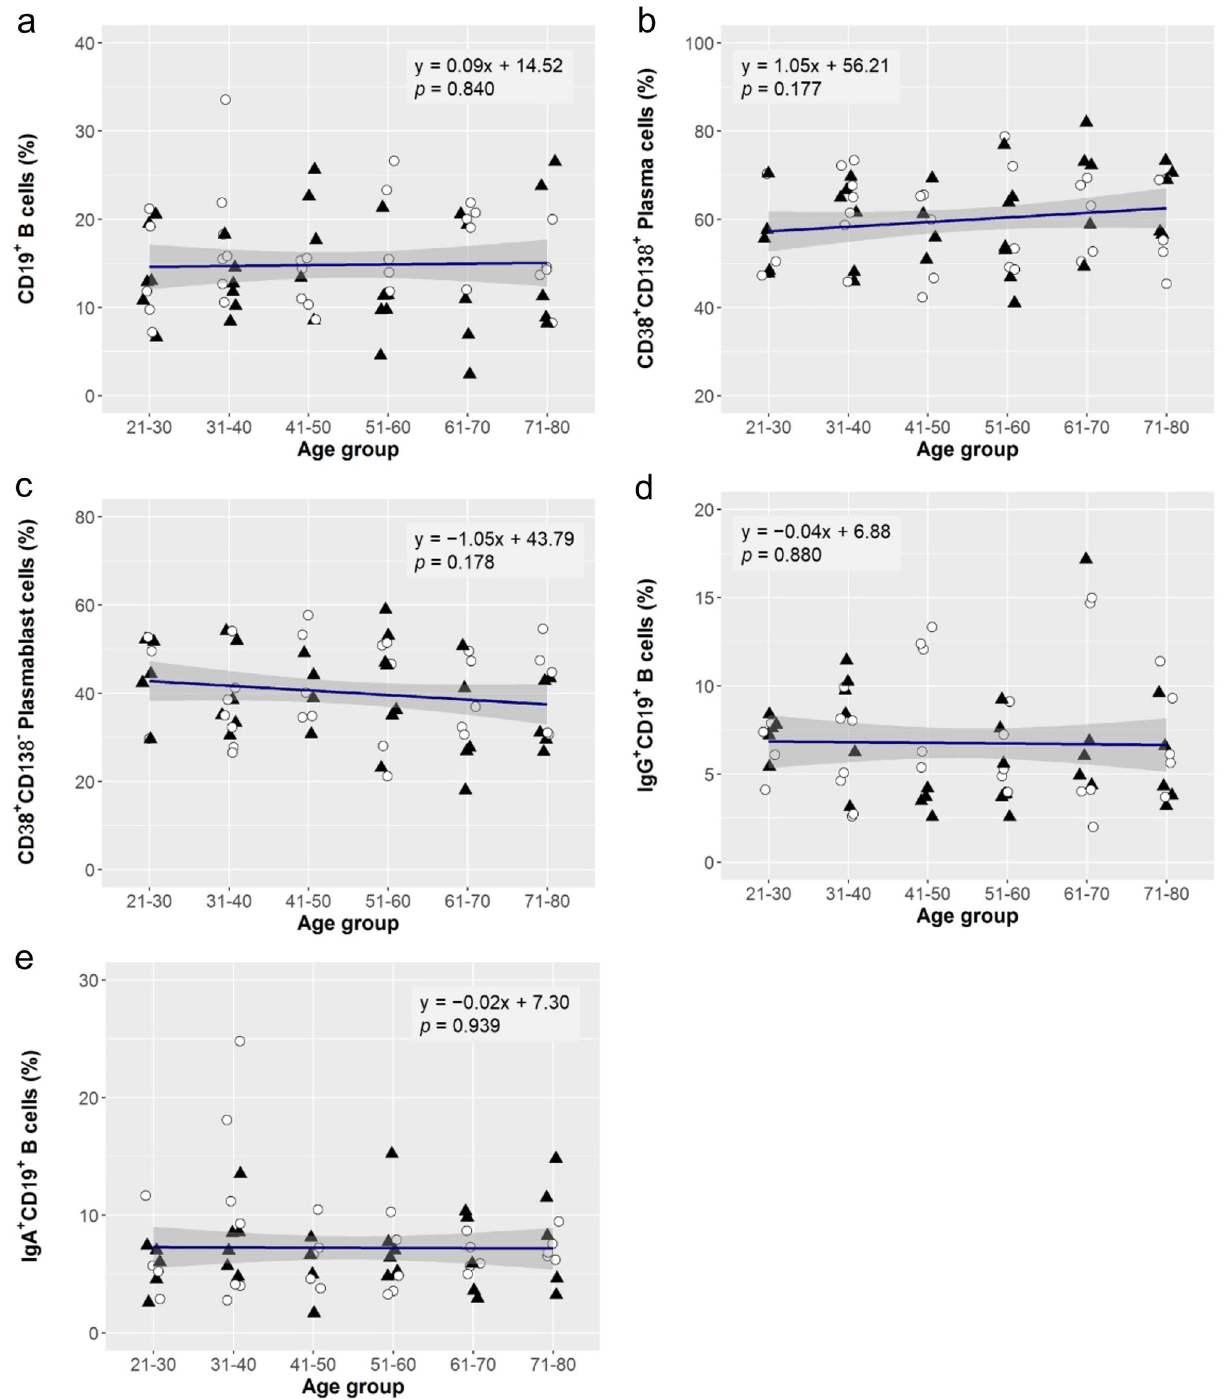
Figure 3. Age-associated changes in B cell subsets. Linear regression analysis to evaluate effect of aging on the frequencies of total B cells ( a ; CD19 + B cells), plasma cells ( b ; CD38 + CD138 + Plasma cells), plasmablast cells ( c ; CD38 + CD138 − Plasma cells), IgG + CD19 + B cells ( d ), and IgA + CD19 + B cells ( e ). The linear regression curve was plotted for the data of 67 subjects (33 females: open circle, 34 males: closed triangle), and its equation and p -value for the effect size of ageing are shown. The statistics of the analysis are summarised in Table